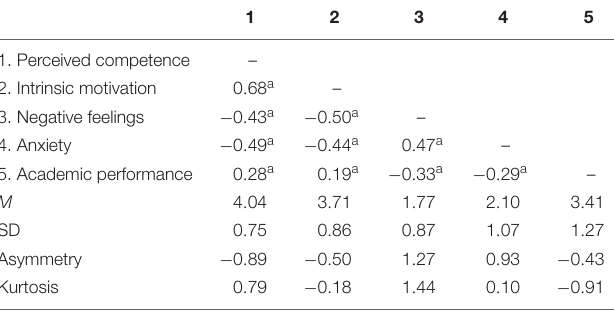
TABLE 1 | Means, standard deviations, asymmetry, kurtosis, and correlation